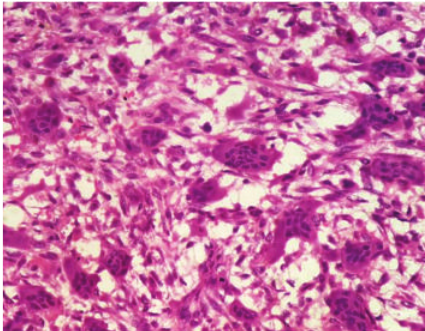
Figure 9: H&E 40x view showing multinucleated giant cells with agglomerate of nuclei in the center with a clear cytoplasmic halo.